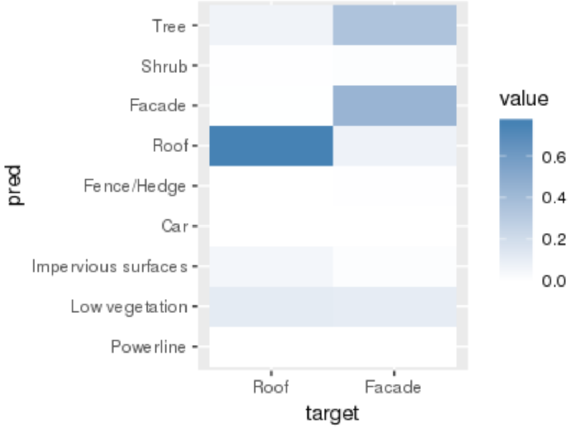
Figure 3. Commission errors per each of the eight labels available in the benchmark